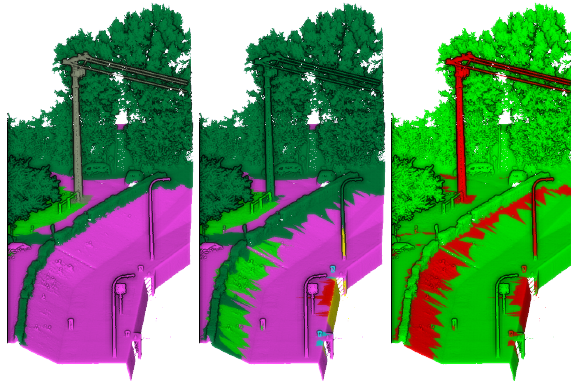
Figure 7. Ground truth and prediction as transferred from the mesh to the point cloud ( left and center ). The correct/false predictions are marked in green/red ( right